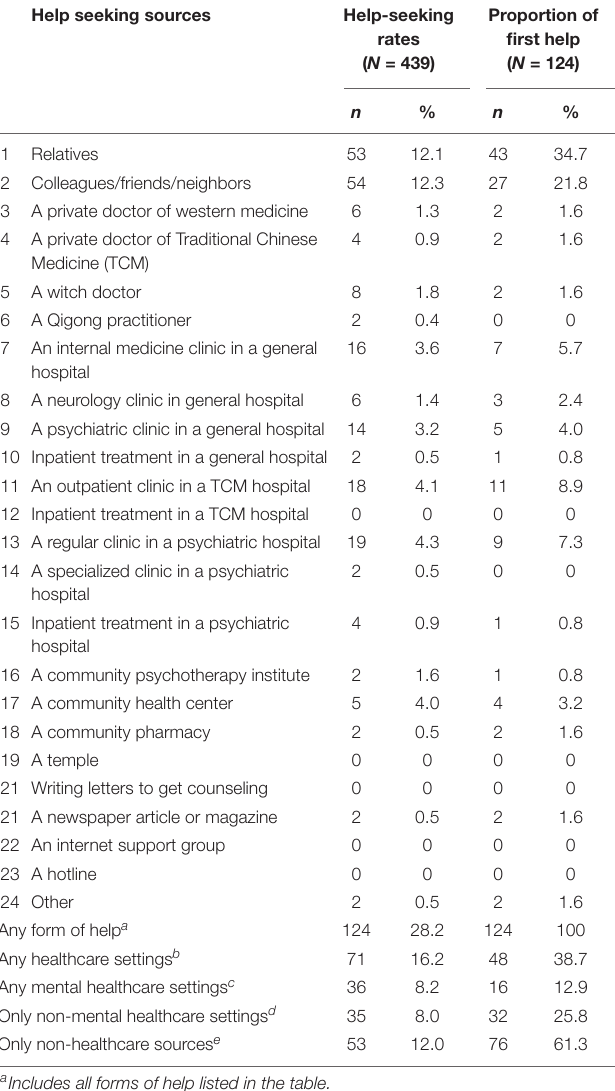
TABLE 2 | The help-seeking rates ( N = 439) and the proportion of first help ( N = 124) for 23 sources in MDD individuals. Help seeking sources Help-seeking